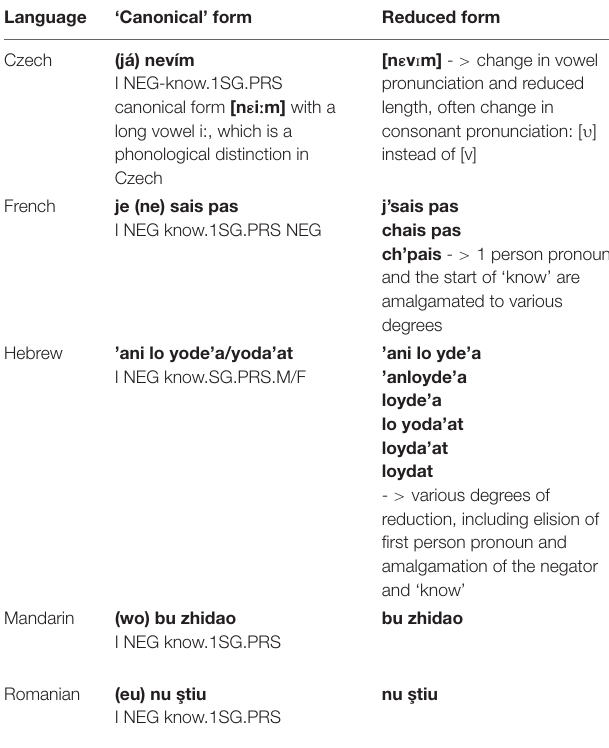
TABLE 1 | Forms of IDKs in the data in five